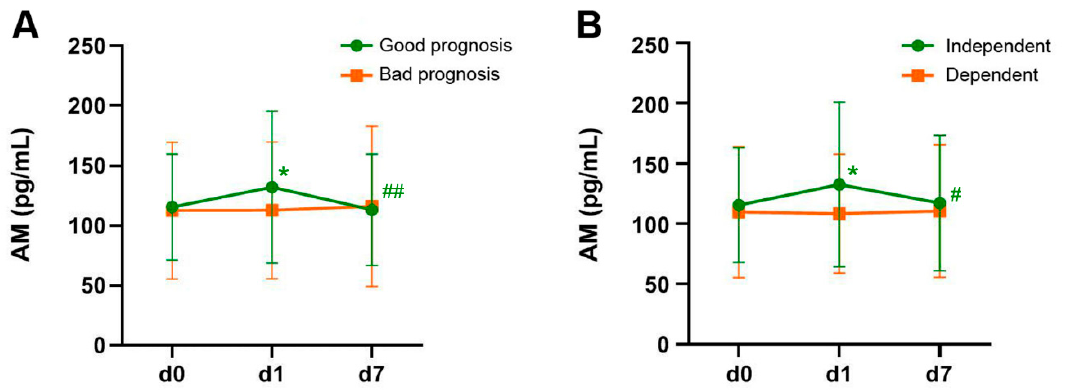
Figure 3. Evolution of AM levels through time in patients with favorable (green lines) or unfavorable (orange lines) outcome, as measured by the NIHSS ( A ) and the mRankin ( B ) scales. Patients with a positive evolution of the disease were characterized by an initial elevation of AM levels from d0 to d1 followed by a decline to initial levels by d7. Patients with unfavorable outcome had no significant changes in AM levels. Bars represent the mean and SD of all patients in the group. *: p < 0.05 vs. d0; #: p < 0.05 vs. d1; ##: p < 0.01 vs. d1.